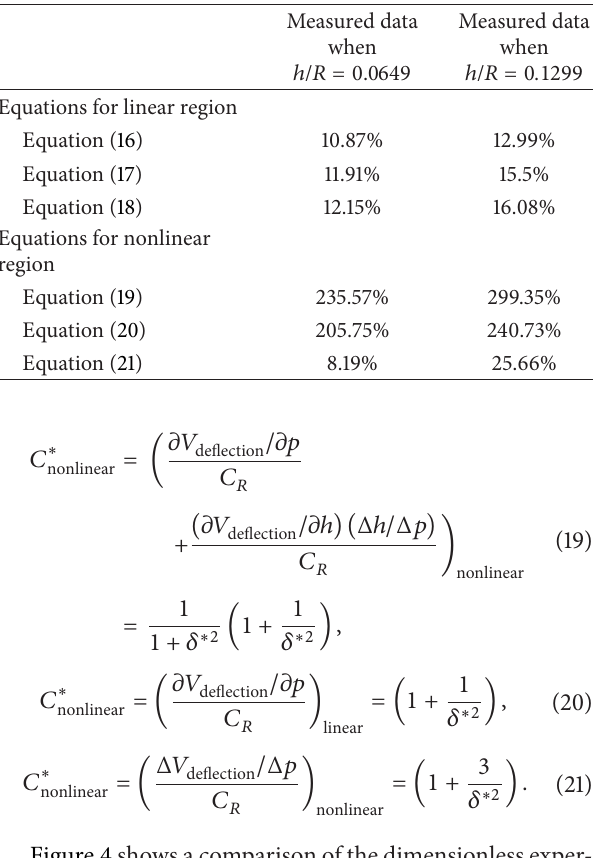
Table 1: Average errors among measured data and